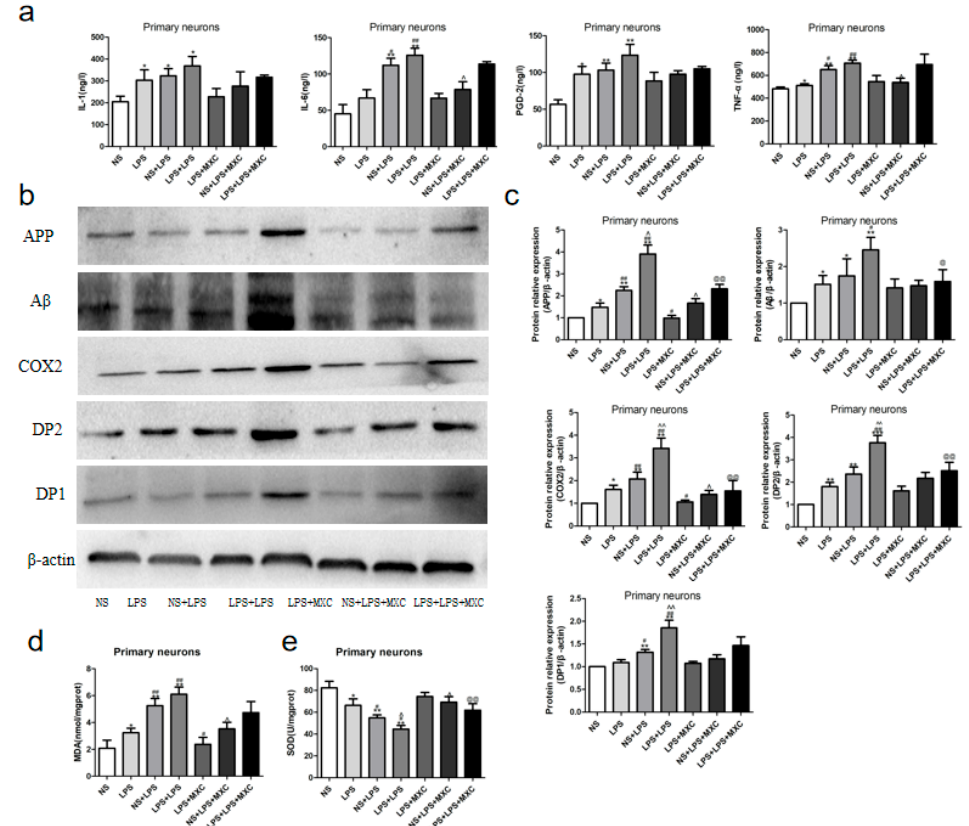
Figure 8. Effect of MXC on inflammatory response protein expressions and oxidative stress in LPS- treated primary neurons of offspring from prenatal inflammation exposure: ( a ) The levels of IL-1 β , IL-6, PGD-2, and TNF- α in the primary cultured neurons ( n = 6). ( b , c ) Western blots analysis of the relative protein contents in the primary cultured neurons. ( b ) The expression of APP, A β , COX-2, DP2, and DP1 was detected by Western blotting using specific antibodies in the primary neurons of rats; protein contents were plotted for NS + CSF, LPS + CSF, NS + LPS, LPS + LPS, LPS + CSF. MXC, NS + LPS + MXC, LPS + LPS + MXC. ( c ) The relative optical density was normalized to β -actin; Each result of the NS group is normalized to 1. ( d , e ) Effect of MXC on the levels of MDA and the activity of SOD in LPS-treated primary neurons of offspring after inflammation during pregnancy. ( d ) and the levels of MDA. ( e ) The activity of SOD. Data are mean ± SEM, n = 4. (* p < 0.05, ** p <